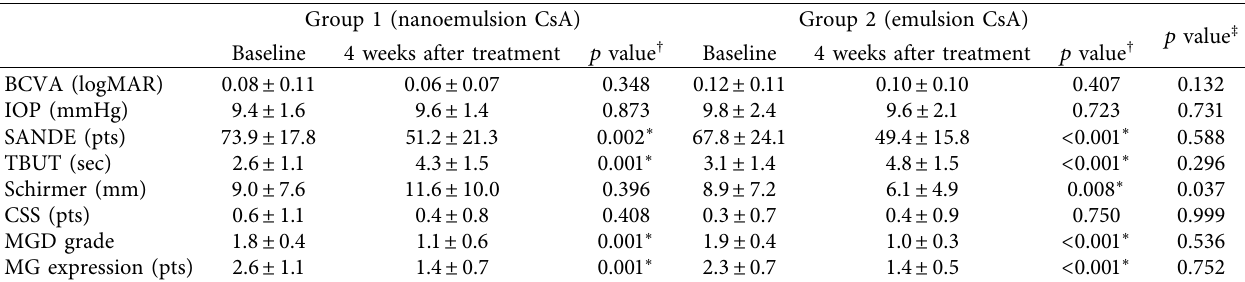
Table 2: Comparison of therapeutic effects at 4 weeks after treatment with topical FML between nanoemulsion and emulsion CsA groups. Group 1 (nanoemulsion